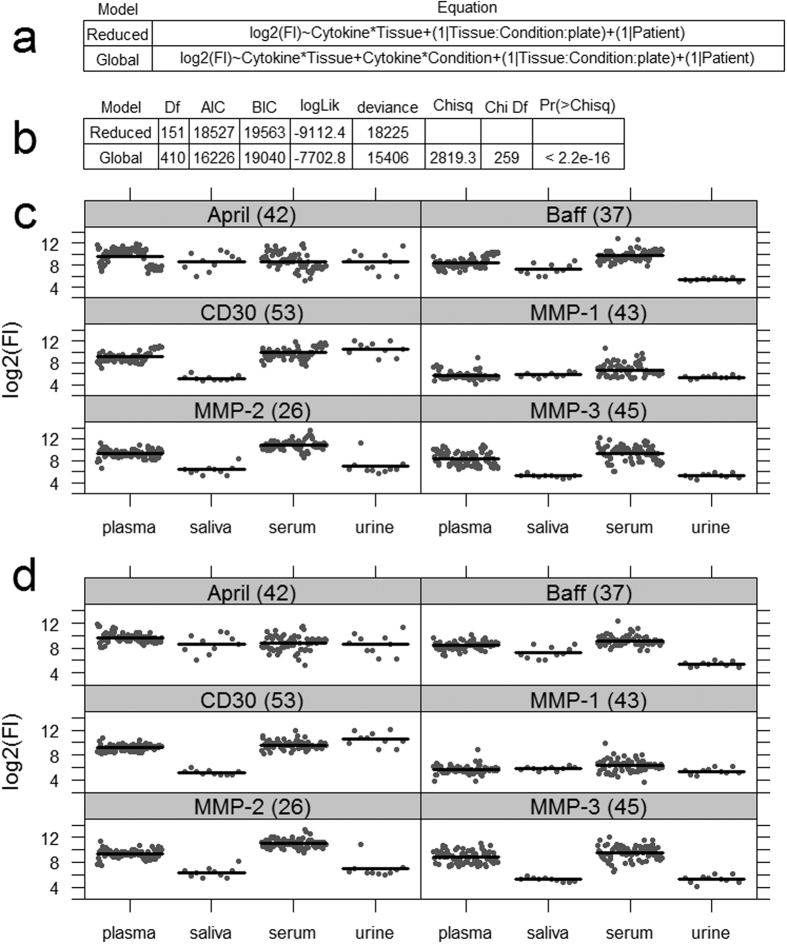
Statistical model for analyte expression.(a) Two linear mixed-effects models in R-notation. Main fixed effects are Cytokine, 37 levels, Tissue, 4 levels, and Condition with 8 levels. (b) Gives the results of a statistical comparison of the reduced model against the global model. AIC Akaike’s Information Criterion, BIC Bayesian Information Criterion, and the smaller they are the better the model fit. Comparisons between reduced, (c), and global mixed-effects models (d) for selected analytes using regression conditional plots. Conditional plots show the relationship between the outcome and explanatory/conditional variables to be viewed as other effects are held constant. Note for the global model, (d), the cluster of points (residuals) around each conditional mean response (dark horizontal line) is tighter than that seen in the reduced model, (c). Both models contain the same number of samples per tissue. For brevity, only results for 9 of the 37 analytes are given, however, the same comparison but for all 37 analytes are given in Supplementary Fig. S2. Since the conditional residuals are reasonably scattered above and below their respective means, implies that either model is a reasonable fit to the data.